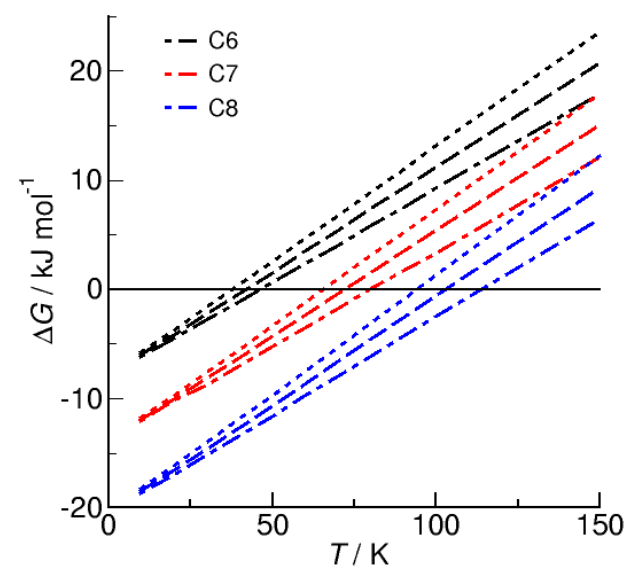
Figure 8. Calculated free energies Δ G for cationic dimers (HCOO − (CH 2 ) 6 − py + ) 2 , (HCOO − (CH 2 ) 7 − py + ) 2 , and (HCOO − (CH 2 ) 8 − py + ) 2 . Decreasing pressures in the order of 1.0 (dash-dotted), 0.1 (dashed), and 0.01 (dotted) atm shift the thermodynamic stability to slightly lower temperatures.